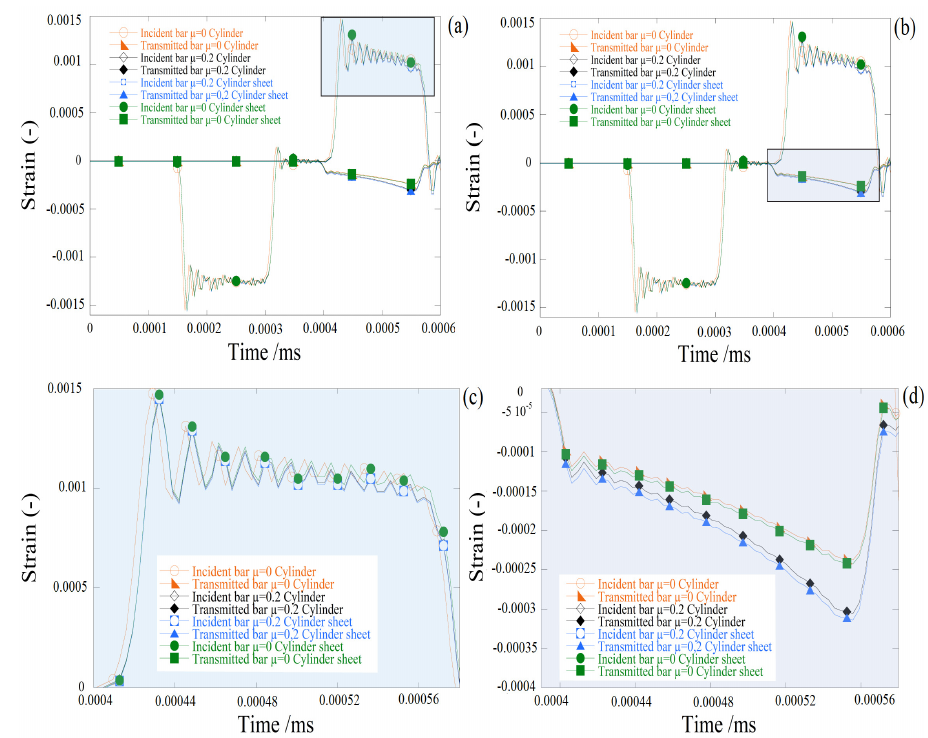
Figure 8. Comparison of cylinder versus cylinder sheet configuration at different friction conditions ( μ = 0 and μ = 0.2). ( a , b ) reflected and transmitted waves ( c ) reflected strain waves and ( d ) transmitted strain waves.